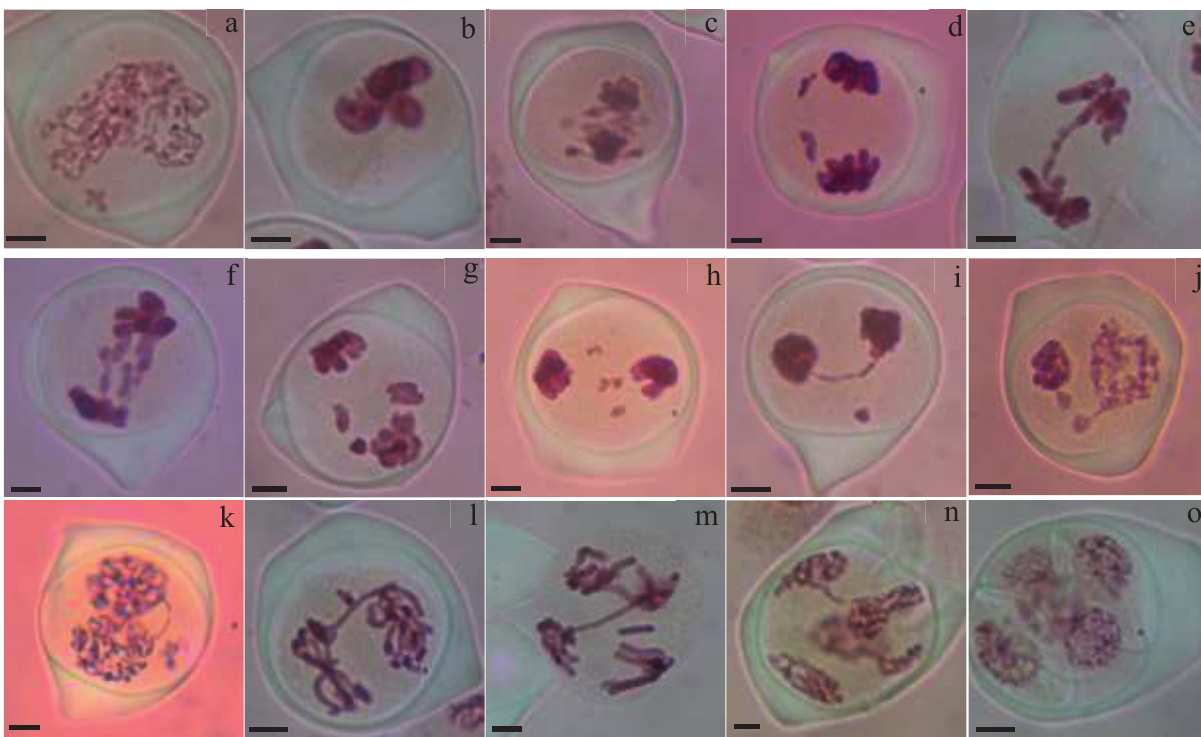
Figure 4. Most frequent meiotic abnormalities in the hybrid Aloe vera x A. jucunda . (a) Micronucleus in prophase-I; (b-c) sticky chromo- somes and early displacement of small chromosomes in metaphase-I; (d-h) acentric fragments in anaphase-I and telophase-I; (e-f) one and two dicentric bridges in anaphase-I; (g) lagging chromosomes in anaphase-I; (i-k-n) bridge and fragment in telophase-I, -II and prophase- II; (j) phase asynchrony between telophase-I and prophase-II; (l) bridging and metaphase-II fragment; (m) bridge and fragment in ana- phase-II and (o) additional microspore at the end of microsporogenesis. Scale bars = 10 µm.